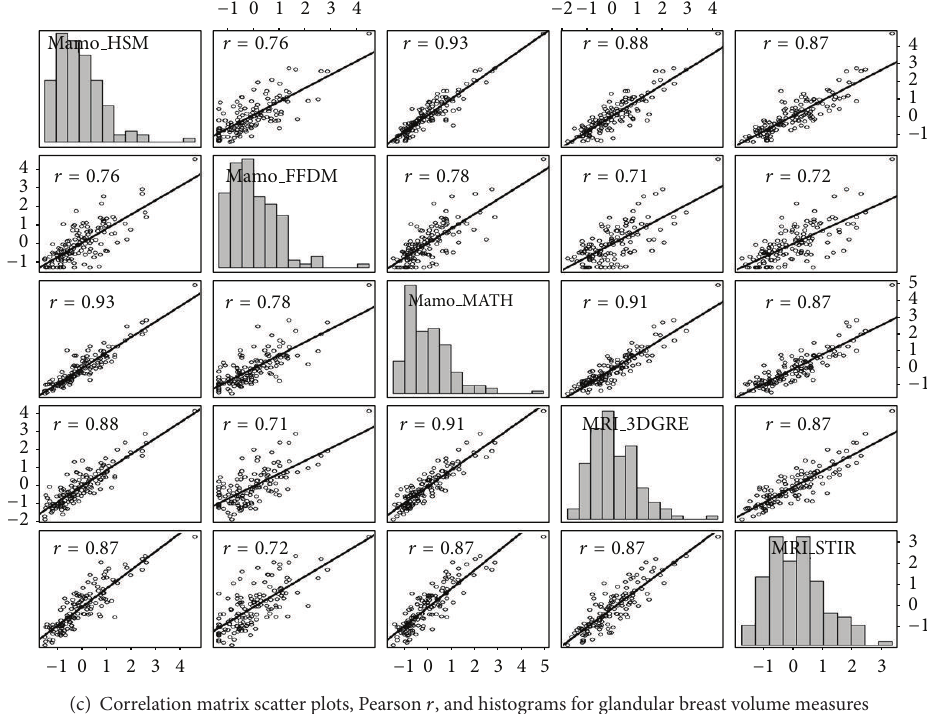
(c) Correlation matrix scatter plots, Pearson 𝑟 , and histograms for glandular breast volume measures